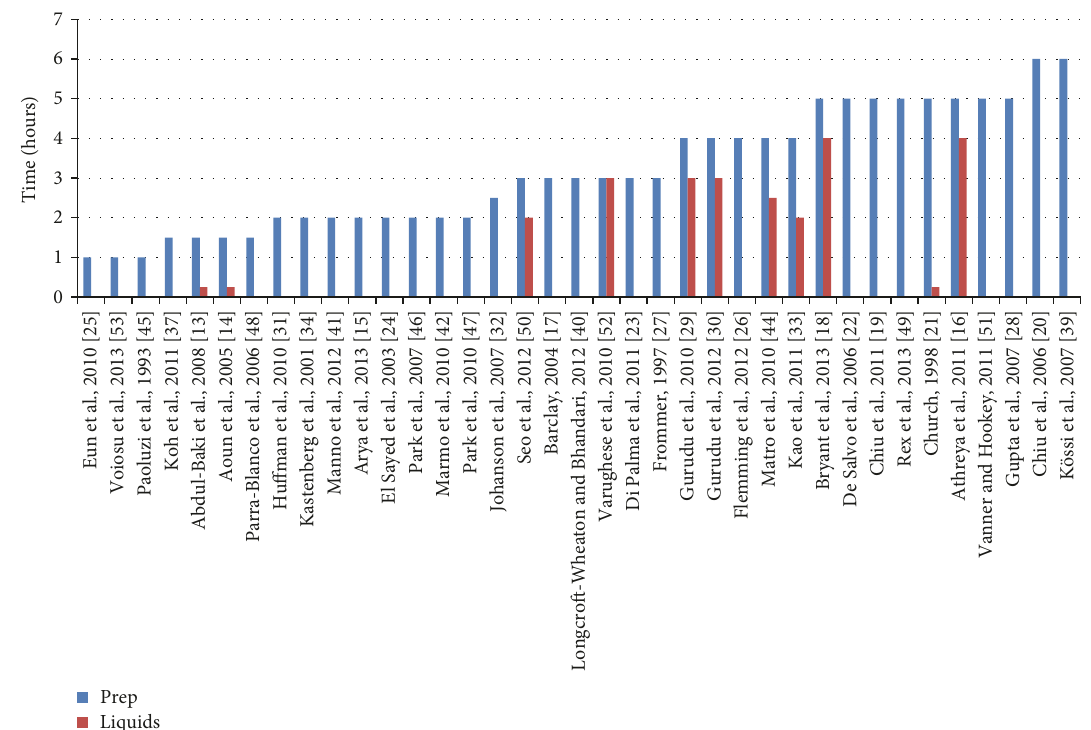
Figure 2: Minimum time from the end of bowel preparation to procedure (blue lines) or time before procedure when liquids were stopped (red lines). Three studies did not provide su ffi cient information to determine a minimum time from the end of preparation to procedure (Khan et al., 2010 [36], Kolts et al., 1993 [38], and Mathus-Vliegen and van der Vliet, 2013 [43]). Studies where patients were allowed liquids until time of procedure are indicated by a time of 0.25 hours. Citations are “ author, year (reference number).